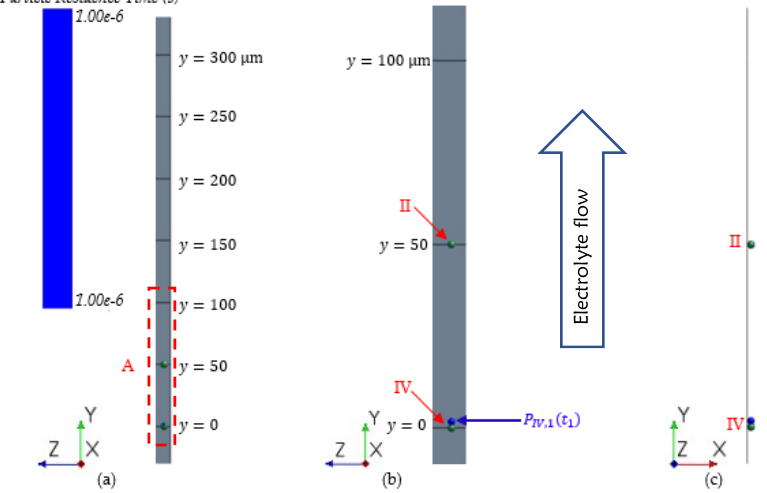
Figure 15 The Star CCM+ simulation results at 𝒕 𝟏 = 𝟏